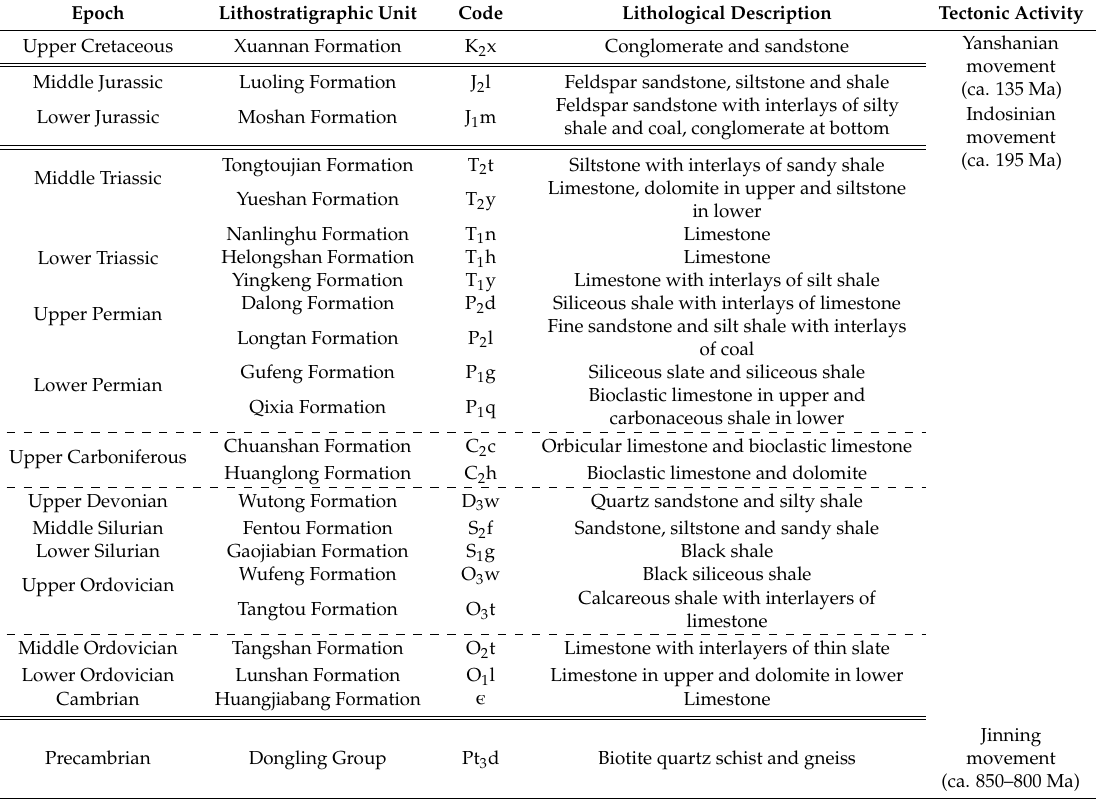
Table 1. Stratigraphy and tectonic events in the Tongling ore district